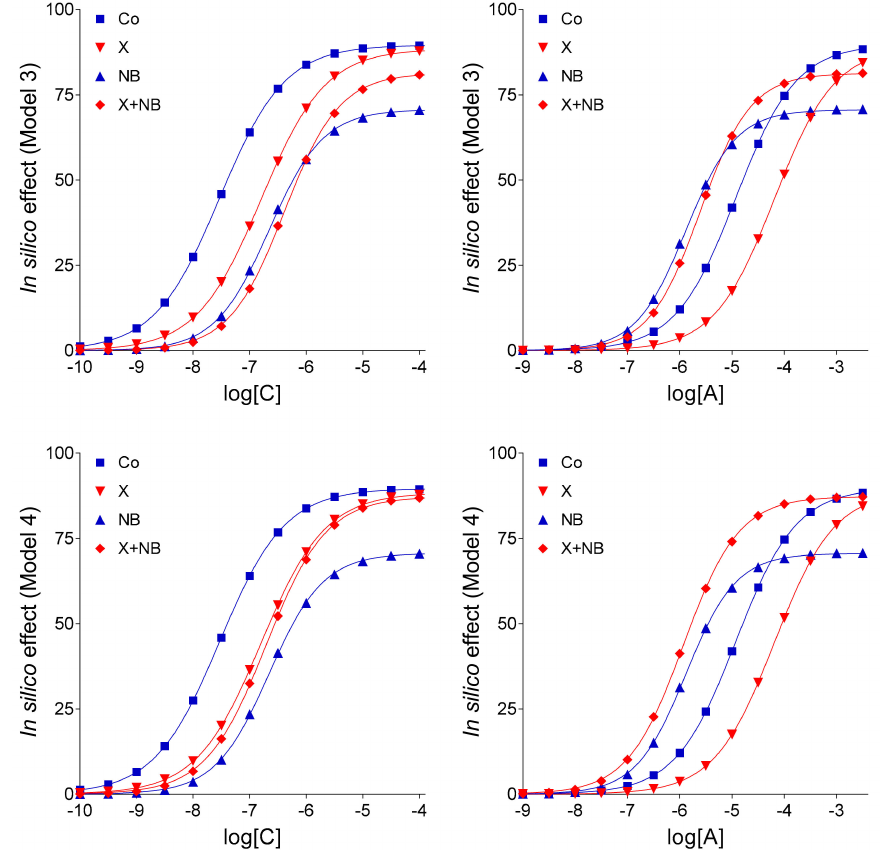
Figure 3. Simulated concentration-response (E / c) curves of agonist C (representing CPA, a synthetic A 1 adenosine receptor agonist with long half-life) and agonist A (symbolizing adenosine, the physiological adenosine receptor agonist with short half-life), according to Models 3 and 4 (modelling the supraventricular myocardium, where A 1 adenosine receptor agonists exert strong direct negative inotropic e ff ect). The E / c curves show the influence of agent NB (representing NBTI, a nucleoside transport inhibitor) on the e ff ect evoked by agonist C and A, without (blue curves) and with (red curves) a pretreatment with agent X (representative of FSCPX, a chemical known as an irreversible A 1 adenosine receptor antagonist). The x -axis denotes the common logarithm of the molar concentration of the given agonist (in the organ bath), and the y -axis indicates the e ff ect. The lines represent the fitted Hill equation (see: Equation (4)). CPA: N 6 -cyclopentyladenosine; FSCPX: 8-cyclopentyl- N 3 -[3-(4-(fluorosulfonyl)benzoyloxy)propyl]- N 1 -propylxanthine; NBTI: S -(2-hydroxy-5-